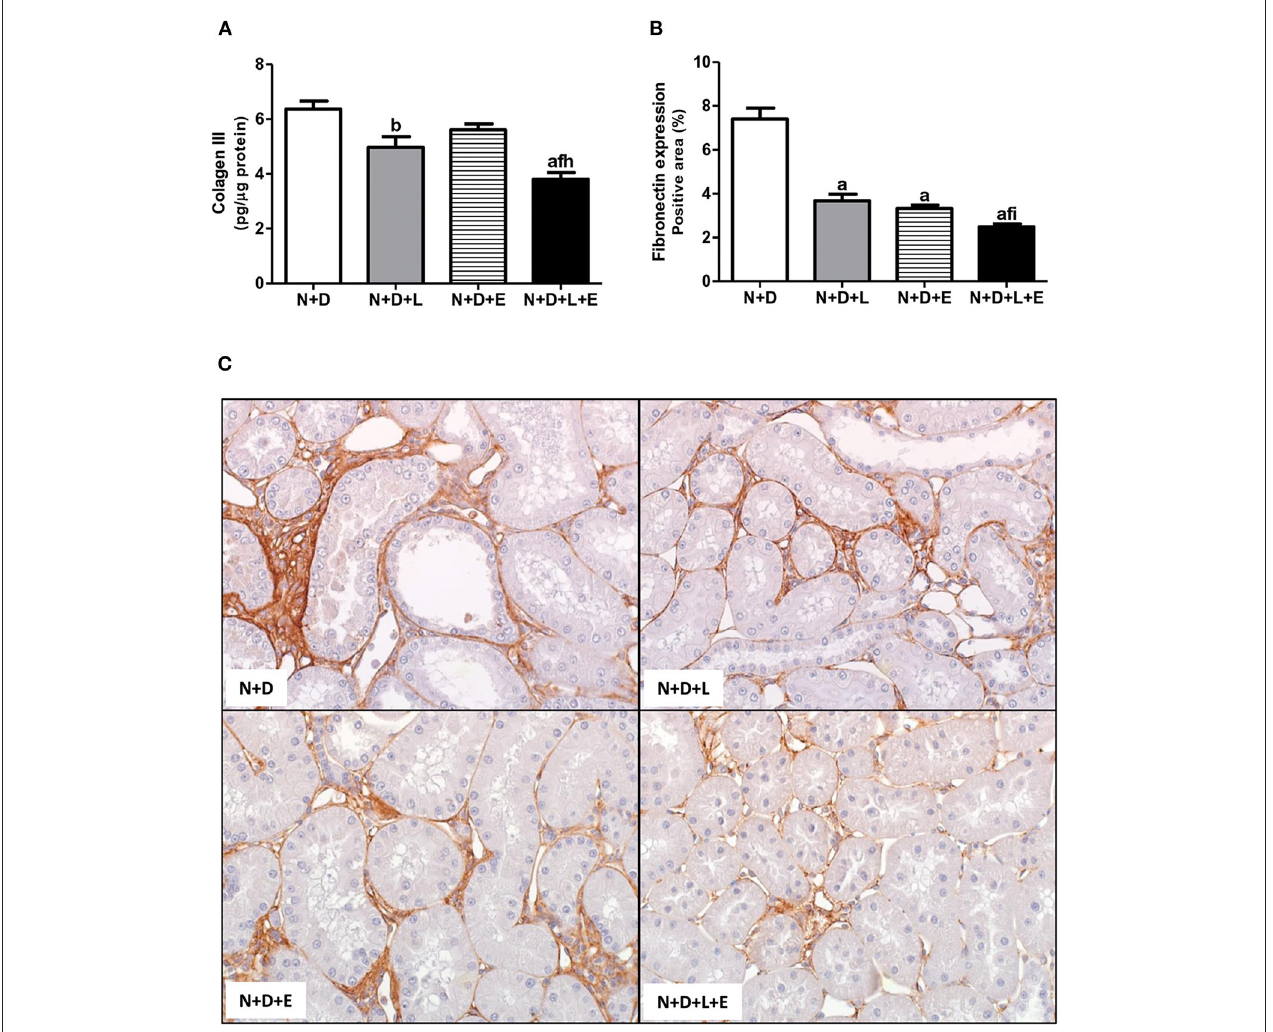
FIGURE 7 | Analysis of extracellular matrix proteins expression in the renal cortex evaluated 60 days after 5/6 nephrectomy in vitamin D-deficient rats treated with losartan, erlotinib or losartan + erlotinib. (A) Quantitative amount of collagen III (Col III) evaluated by ELISA in N + D, N + D + L, N + D + E and N + D + L + E groups. (B) Bar graph of immunohistochemical analysis of fibronectin expression in N + D, N + D + L, N + D + E and N + D + L + E groups. (C) Representative photomicrographs of immunostaining for fibronectin in the renal cortex from a N + D, N + D + L, N + D + E and N + D + L + E rat (x400). Note that fibronectin expression is significantly lower in the N + D + L + E than in the other groups. a p < 0.001, b p < 0.01 vs. N + D; f p < 0.05 vs. N + D + L; h p < 0.01, i p < 0.05 vs. N + D + E. N, 5/6-nephrectomized rats; D, vitamin D-deficient rats; L, losartan-treated rats; E, erlotinib-treated rats; L + E, rats concomitantly treated with losartan + erlotinib. N + D ( n = 10); N + D + L ( n =